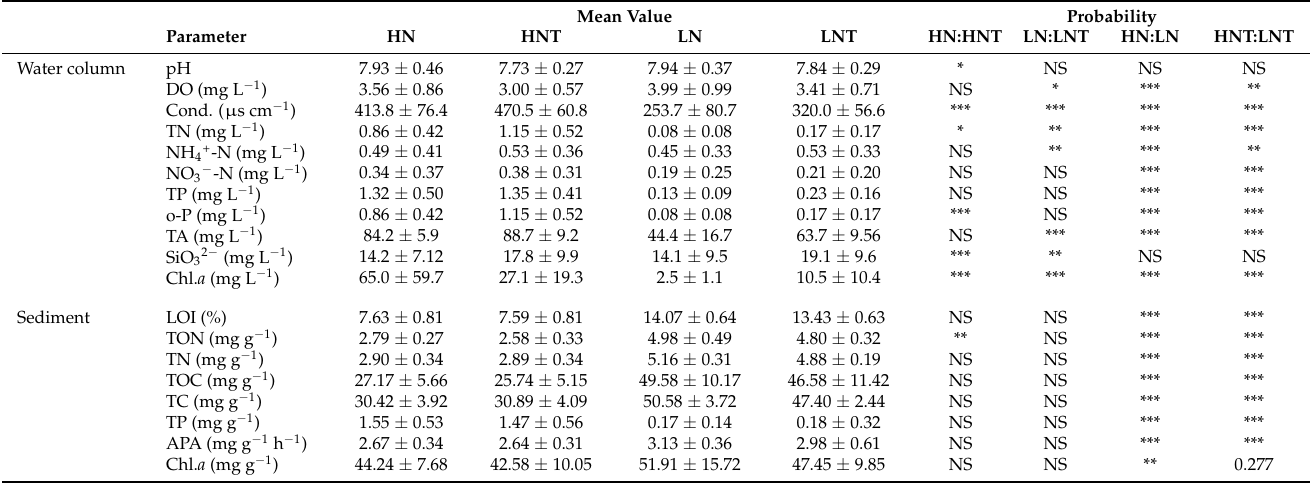
Table 1. Mean effects of temperature (T) and nutrient (N) on measured variables in 24 mesocosms between March and October (N = 42). Abbreviations used: ambient, A; heated, H; low nutrient, LN; high nutrient, HN; not significant, NS. Wherever results were significant, p values are indicated as ***: p < 0.01, **: p < 0.05, *: p < 0.1. Mean Value Probability Parameter HN HNT LNT HN:HNT LN:LNT